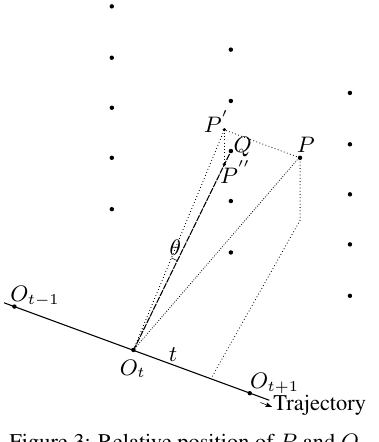
Figure 3: Relative position of P and Q